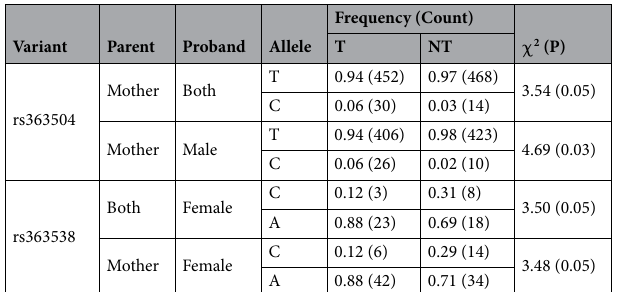
Table 2. Analysis of parental transmission to the probands. N.B: T = Transmitted; NT = Not